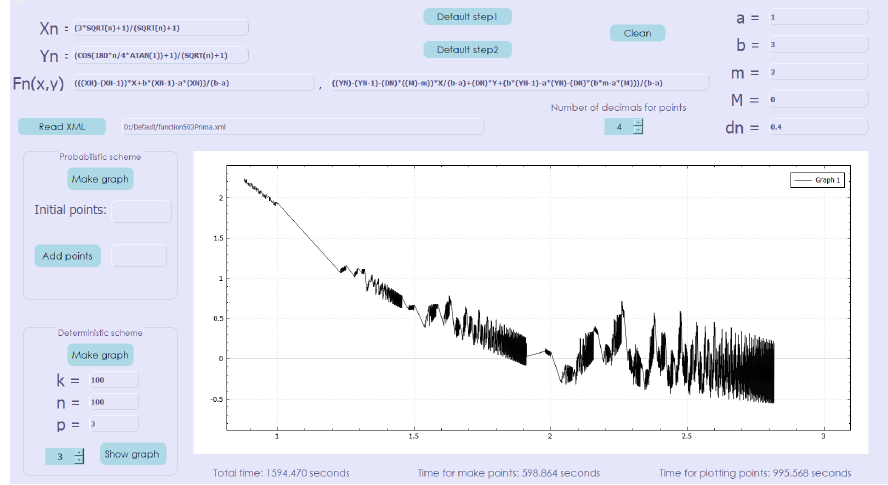
Figure 6. Affine deterministic interpolation scheme (approximation with 100,000,000 points).